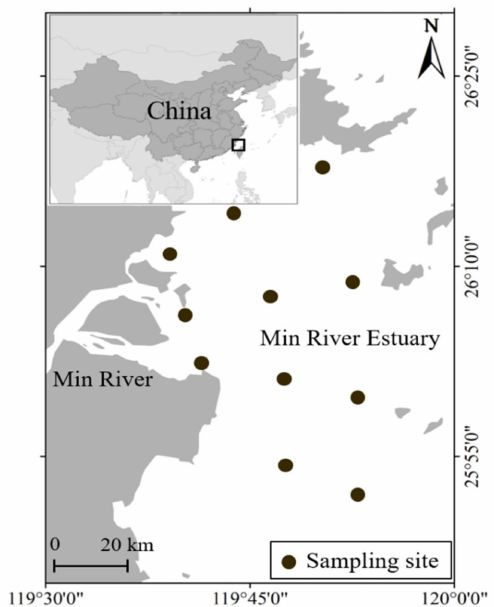
Figure 1. Fish sampling stations in the Min River Estuary, the biggest estuary in southeastern